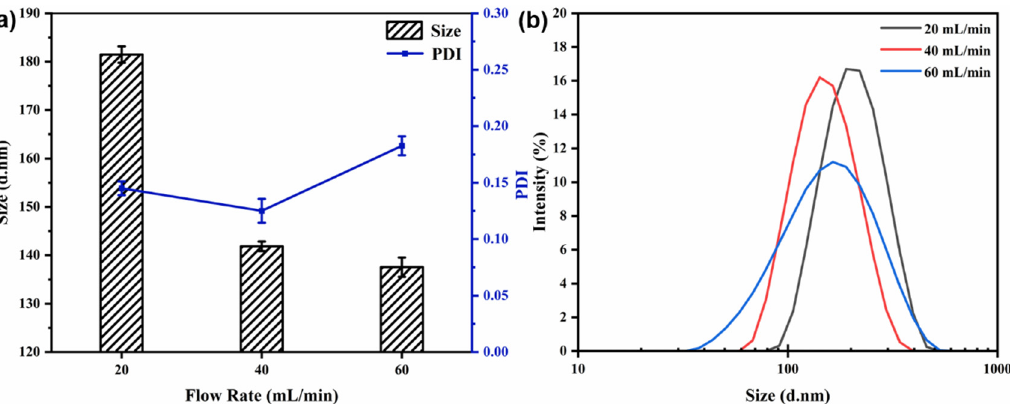
Figure 4. Effect of flow rate on particle size and PDI ( a ) and size distribution ( b ) of